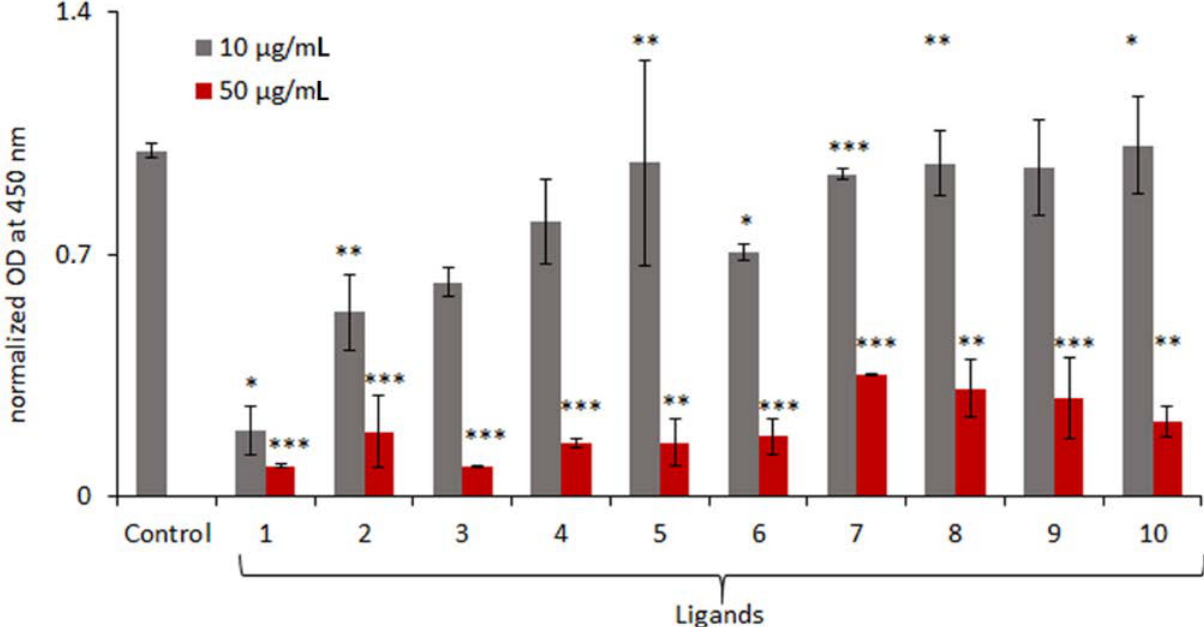
Figure 1. Cell viability analysis assessed by WST-1 assay. A375 melanoma cells are treated with small heterocyclic ligands with 10 and 50 µ g/mL concentrations for 24 hours. Data are normalized to untreated cells and represent mean OD values ± s.d. from triplicate experiments. Data are statistically evaluated, and *, **, and *** denote p < 0.05, p < 0.01 and p < 0.001, respectively, compared with the